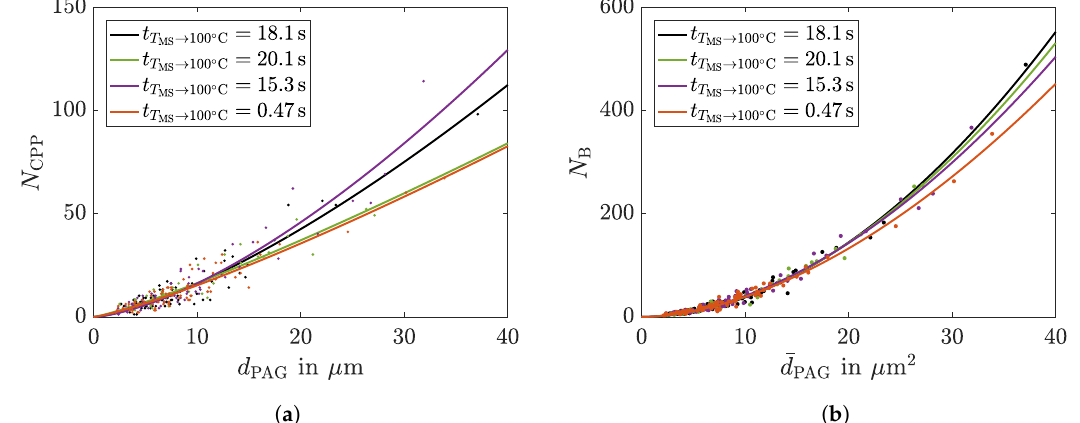
Figure A2. Number of blocks in ( a ), and packets in ( b ) depending on the prior austenite grain (PAG) cross-section